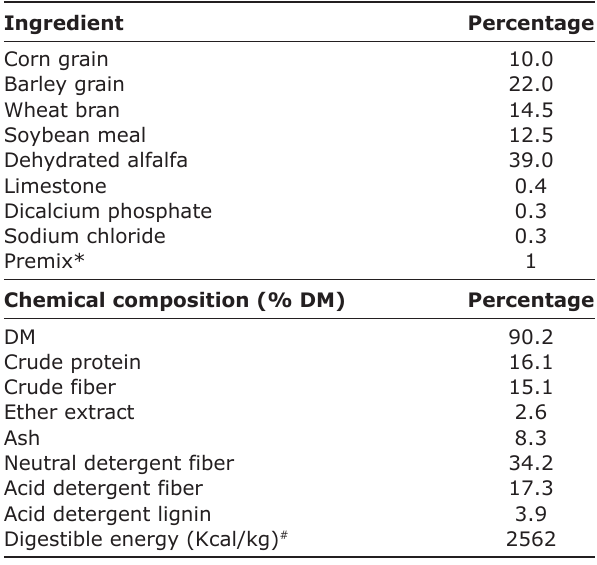
Table-1: Composition and chemical analysis of the diet. Ingredient